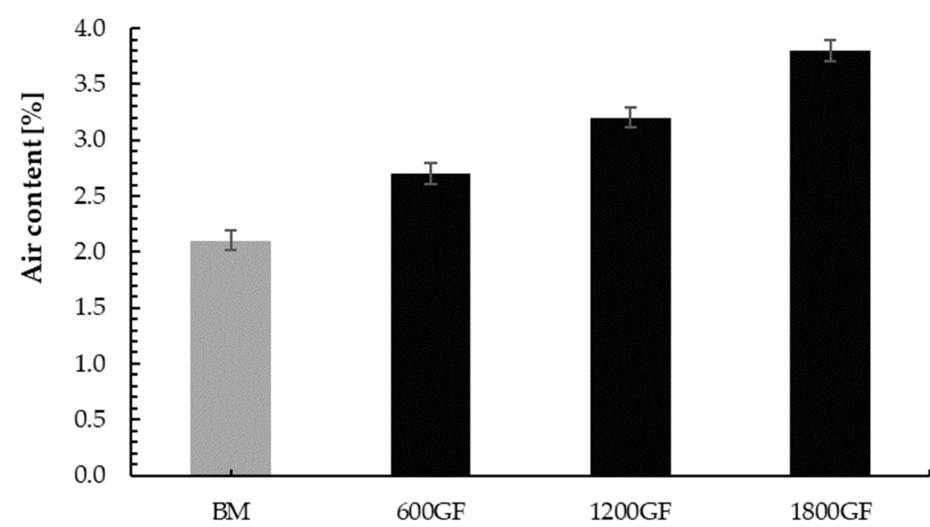
Figure 6. Air content of tested mixes: GF marked in black, base mix (no fibers) marked in dark grey.